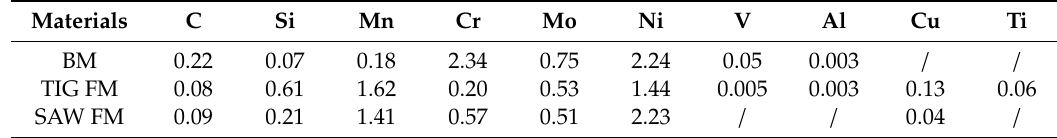
Figure 1. The schematic welded rotor simulator and the dimensions and location of the metallographic specimens. Table 1. The composition of base metal and filler metals (wt.%).